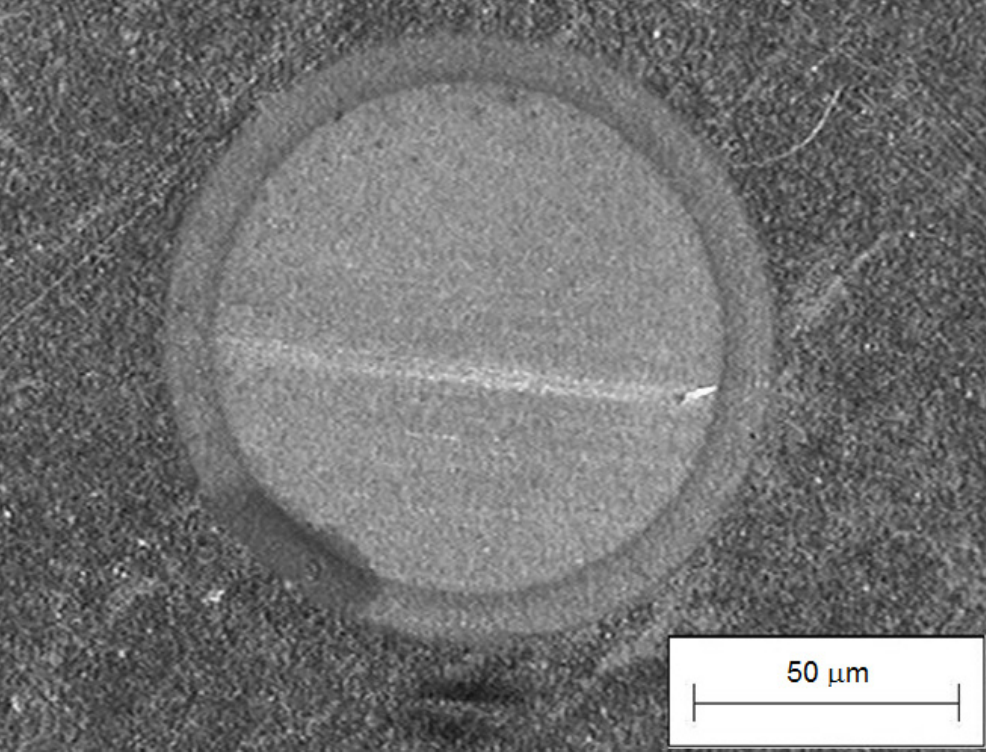
Figure 5. Crater produced in TiN-coated steel sample by optical